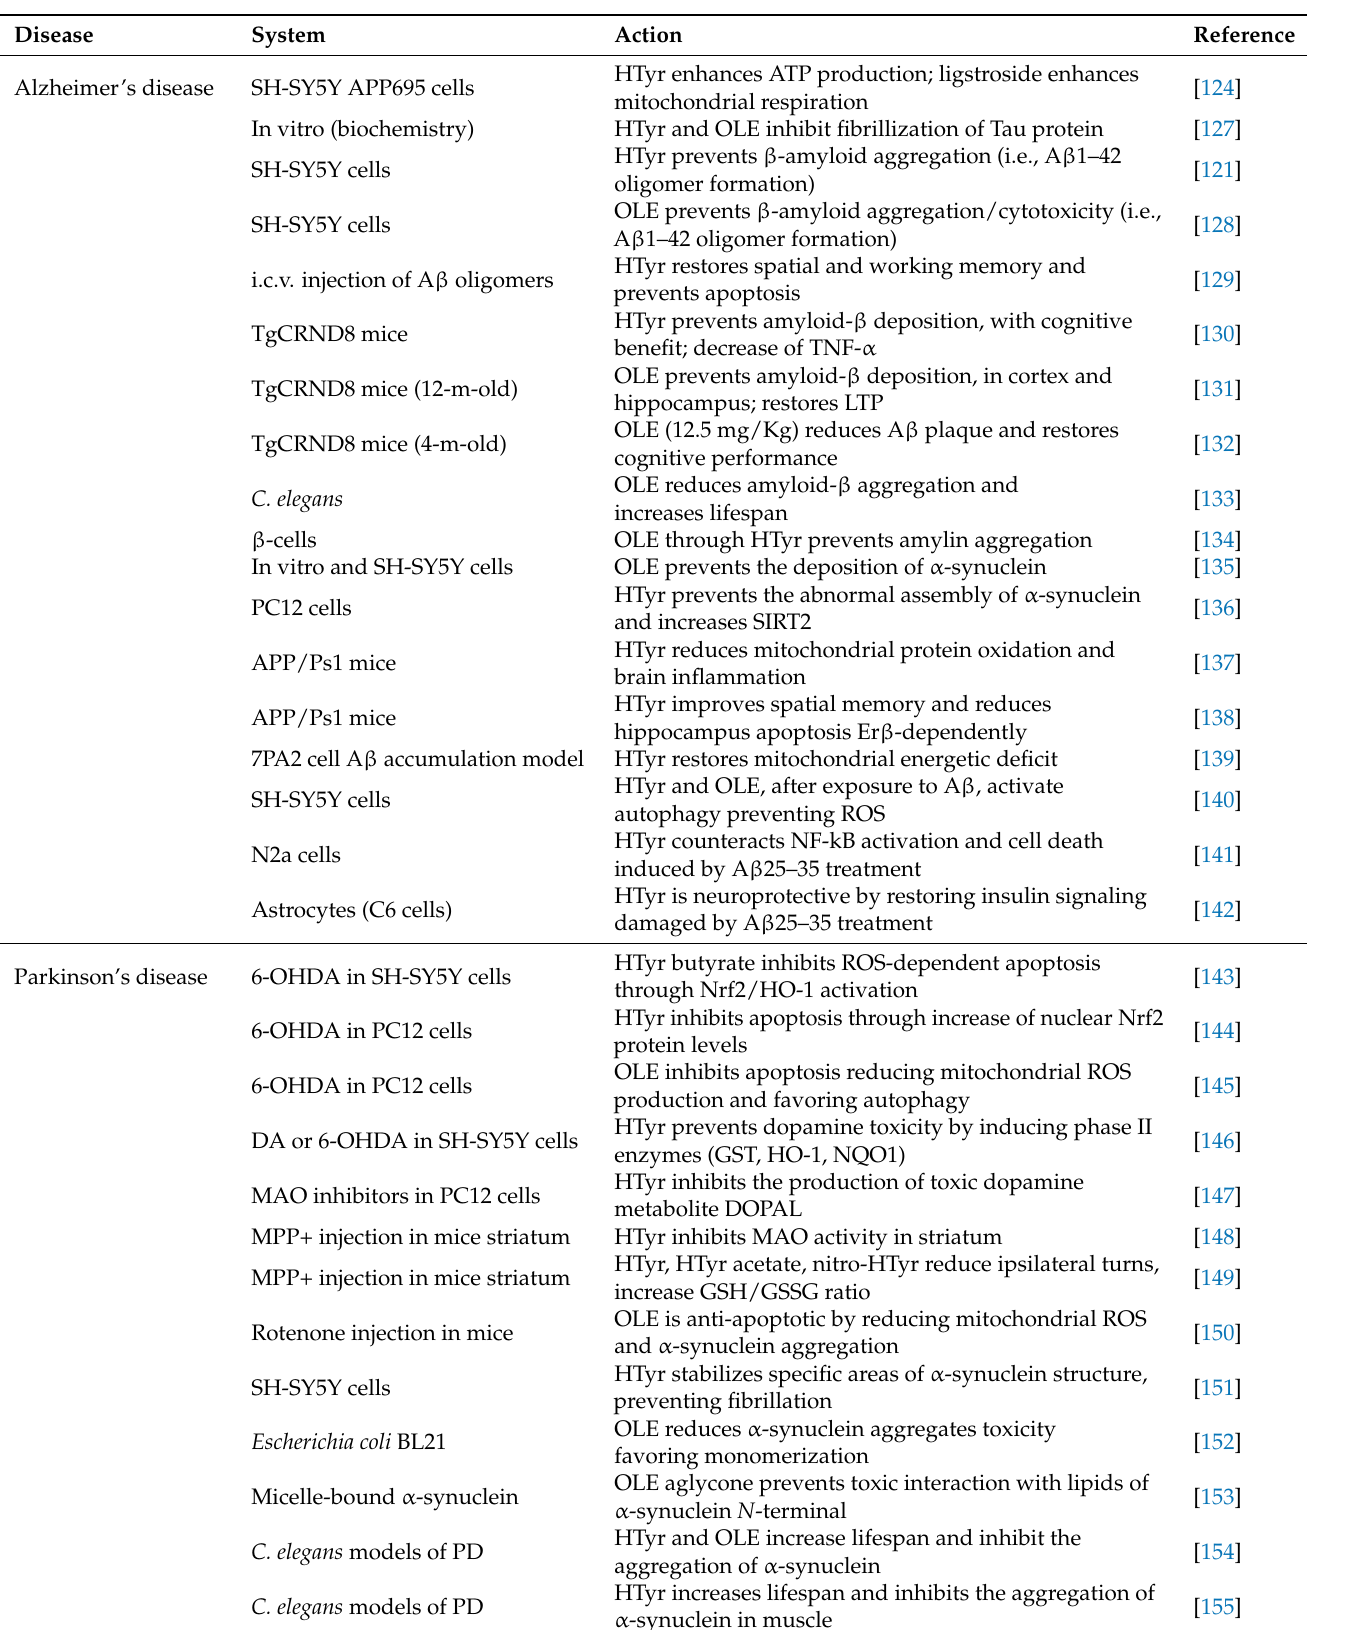
Table 1. Effects of HTyr or OLE on age-associated neurodegenerative diseases.